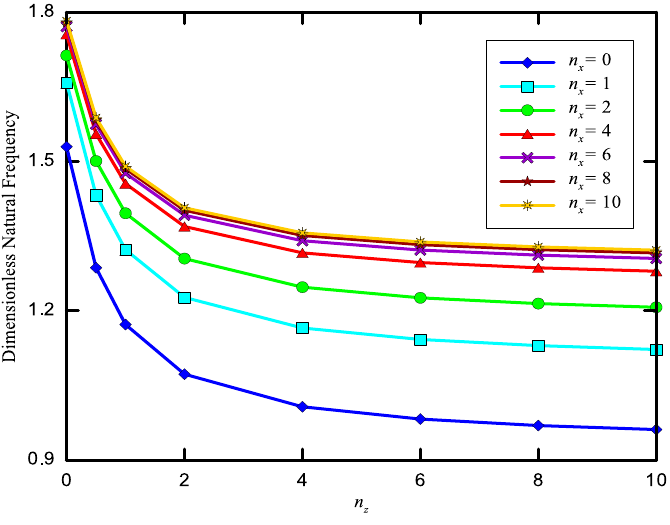
Fig. 5. Variation of non-dimensional natural frequency 𝛚̅ with nz for a simply supported sandwich